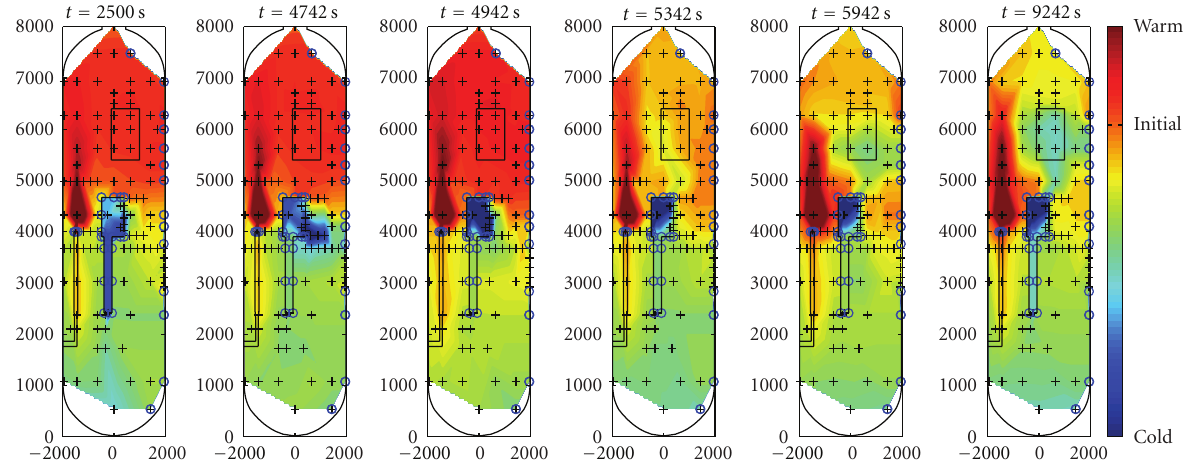
Figure 8: Temperature contour maps in Vessel 1 for experiment ST4 2 for di ff erent instances in time.